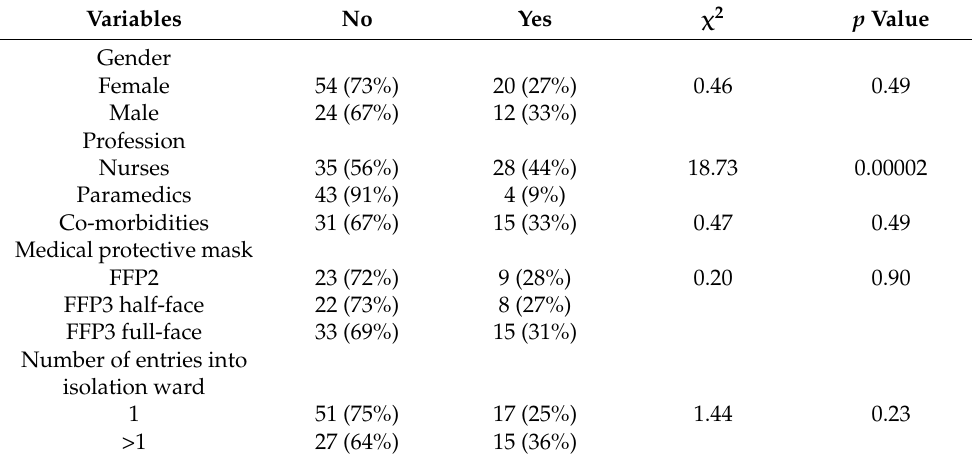
Figure 1. Physical symptoms reported by participants after taking care of COVID-19 patients in isolation wards. Table 3. Physical symptoms reported by participants after caring for patients with COVID-19 in isolation units and variables (n =